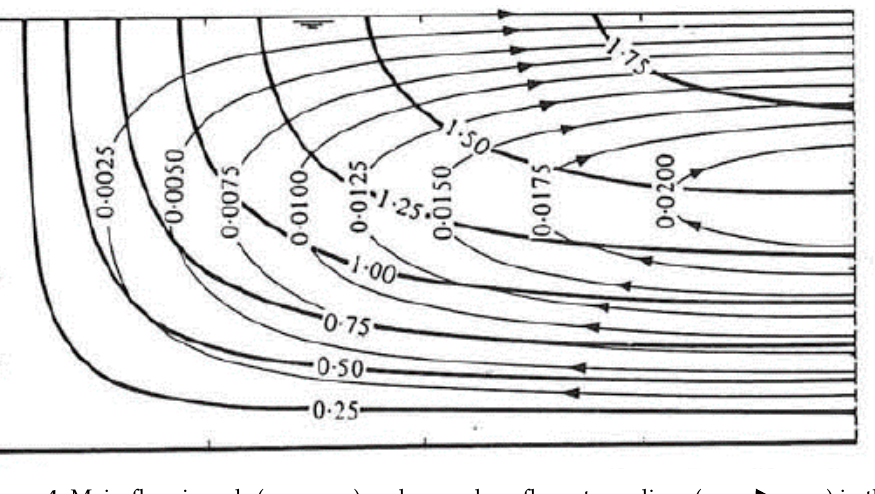
Figure 4. Main-flow isovels ( ) and secondary-flow streamlines ( ) in the inner wall region of a shallow channel (d/B = 0.1) (De Vriend, 1980) [4] .